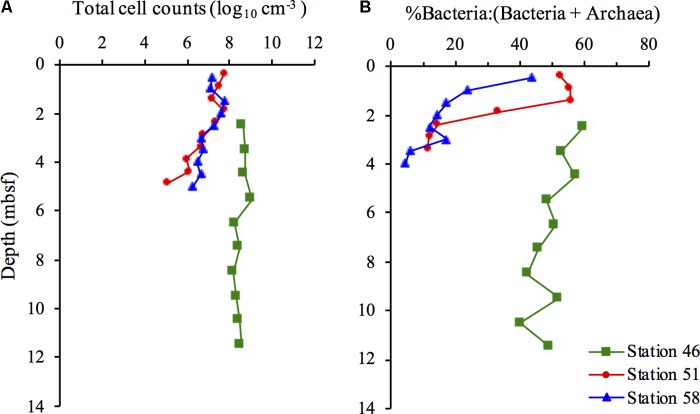
Distribution of total cell counts (A) and the relative contribution of Bacteria to (Bacteria + Archaea) (B) at Station 46, 51, and 58.